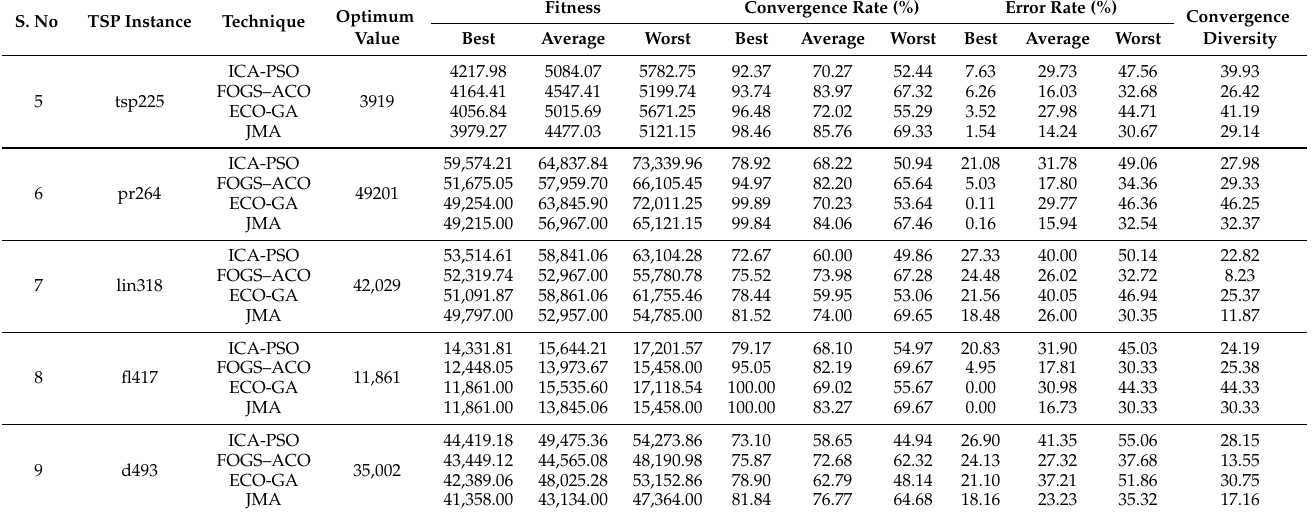
Table 10. Medium-scale TSP instances.